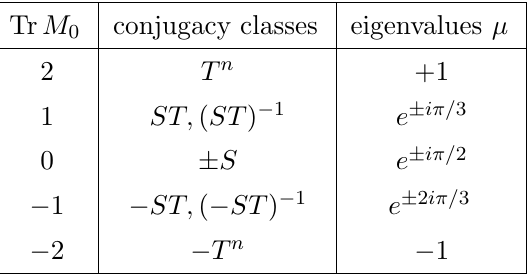
Table 4 . Representatives of all elliptic and parabolic conjugacy classes of SL(2 ; Z ). n is an